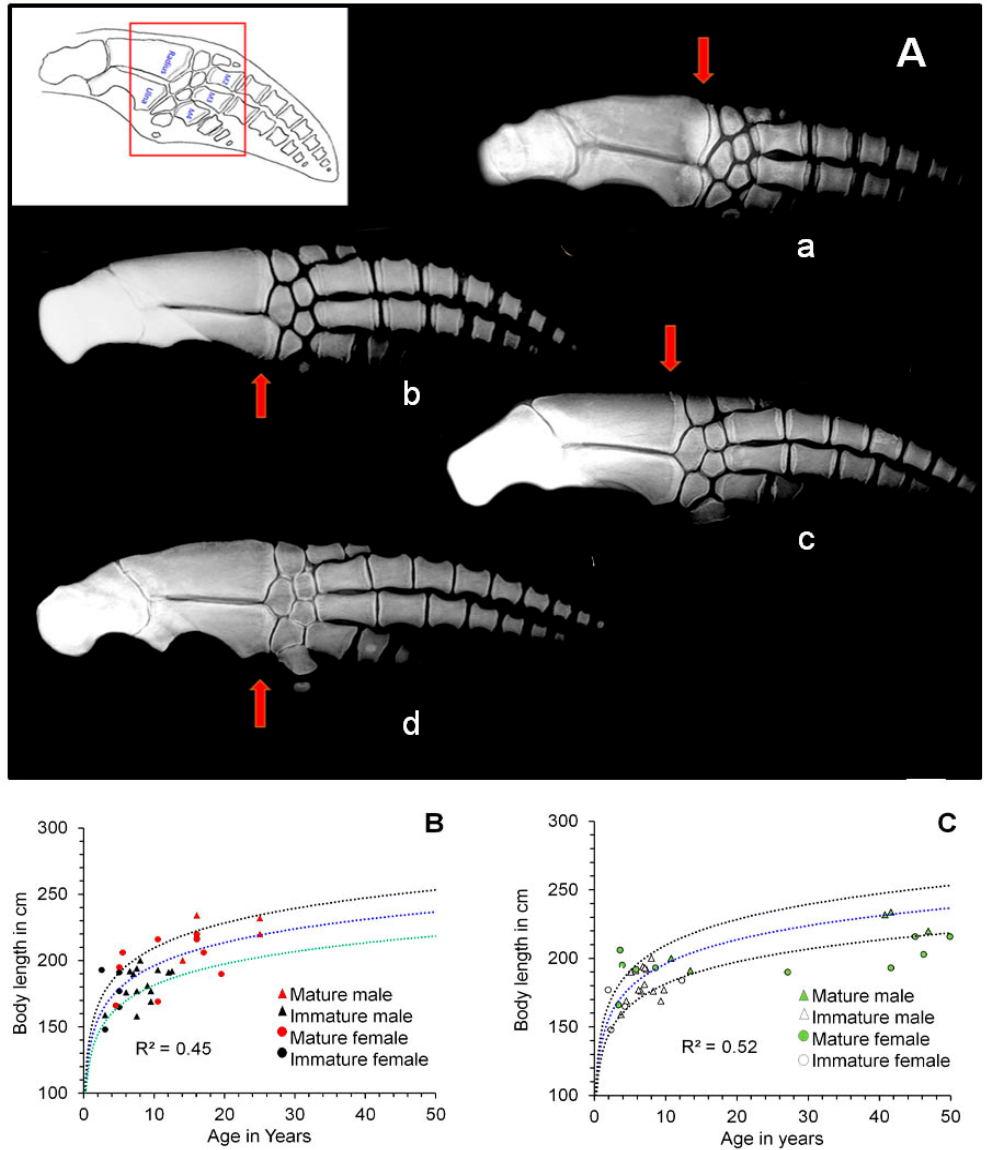
Figure 2. S. coeruleoalba age estimation according to body length and pectoral flippers bone characters. ( A ) X-ray radiography of the epiphysis of radius, ulna, and metacarpals of pectoral flippers was used for age evaluation (insert, red square insert). Arrows point to the radioulnar epiphysis used for age evaluation. ( a ) radio-ulna epiphyses radiolucent at stage 3 of pre-weaned female (CR05-20), of ~2.5 years old; ( b ) trabecular bridge visible of a juvenile female (CR01-18) epiphyses at stage 4 of ~ 7 years old; ( c ) ghost physis present in a female, young adult (CR05-19) at stage 5 of ~11.5 years old; and ( d ) adult male (CR10-20) at stage 6 of > 25 years old years, where remodeling of the physical region and replacement of the physeal line by mature bone tissue occurs. ( B ) Correlation between FBSA and body length. ( C ) Correlation between FBF (x = 0.000383y 3 − 0.0019398y 2 + 0.1101071y − 0.2517343) and body length. The dotted curves denote three dolphin age models according to Stenella dolphins’ body length [3,6,53,54]. R 2 denotes the proportion of variation of age estimation according to flippers’ bone characters with body length. (Details in Supplemental Data S1). The formulas for the slope of the curves are depicted in Figure